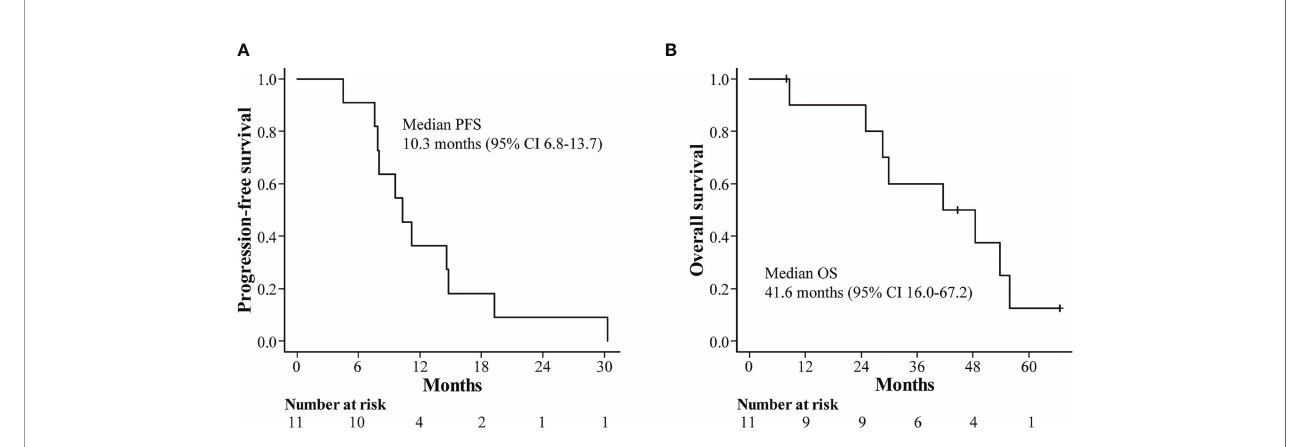
FIGURE 2 | Kaplan-Meier estimates of survival outcomes. (A) progression-free survival. (B) overall survival. CI, con fi dence